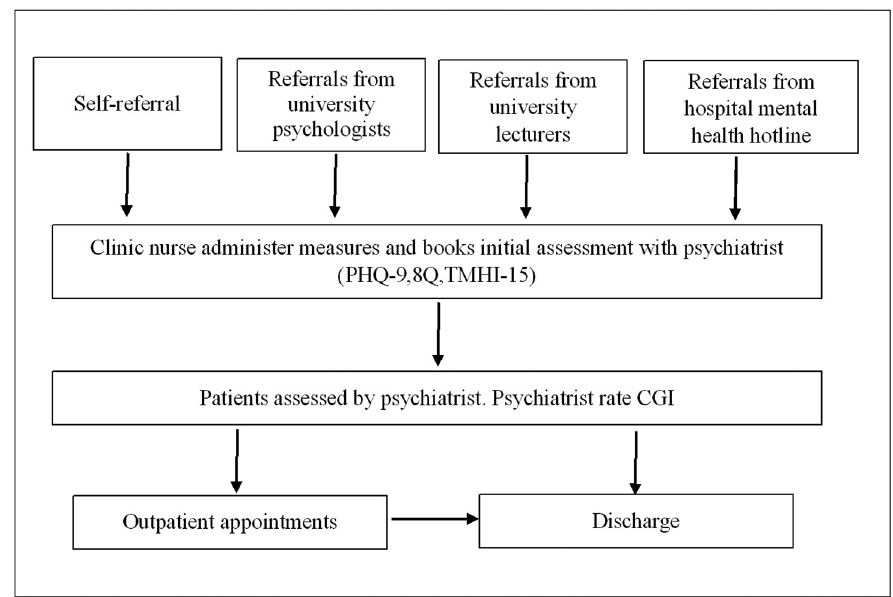
Figure 1. Supara mental health service process